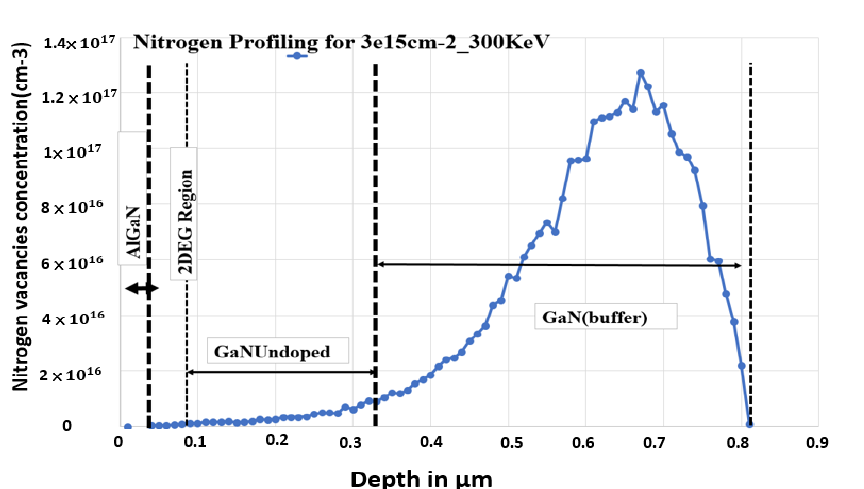
Figure 3. The depth profile of the nitrogen vacancies created by 300 KeV energy carried out by using TRIM simulation.